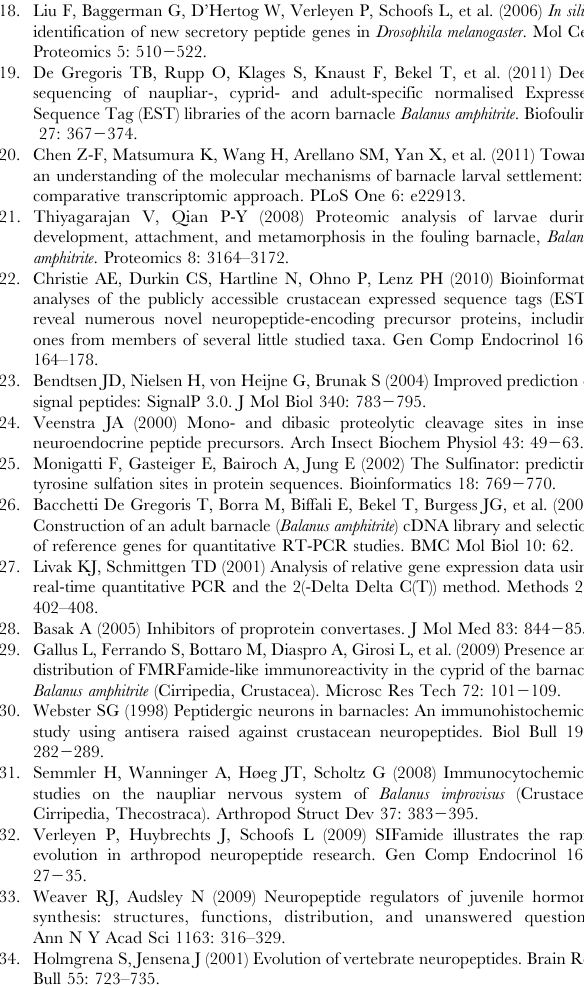
Table S1 Mature neuropeptides/peptide hormones predicted from Balanus amphitrite . (PDF) Table S2 Precursor sequences of neuropeptides and peptide hormones from Balanus amphitrite . Signal peptides are marked as green letter, precursor related peptides are marked as blue letter, and mature neuropeptides are marked as red letter. The putative mono-, di- or tribasic cleavage sites are underlined, and amino acid residues that predicted to be sulfated are shaded as pink. (PDF) Table S3 Primers used for real-time PCR